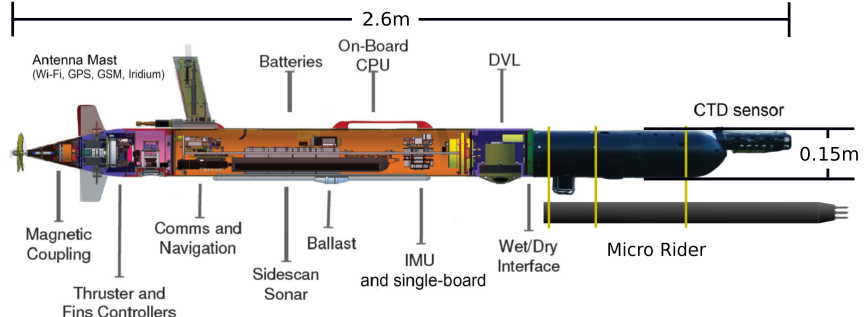
Figure 2. Sketch showing the AUV used on this mission, with instruments and hardware as indicated. This sketch is a modified version of a figure in Fossum et al. (2021).